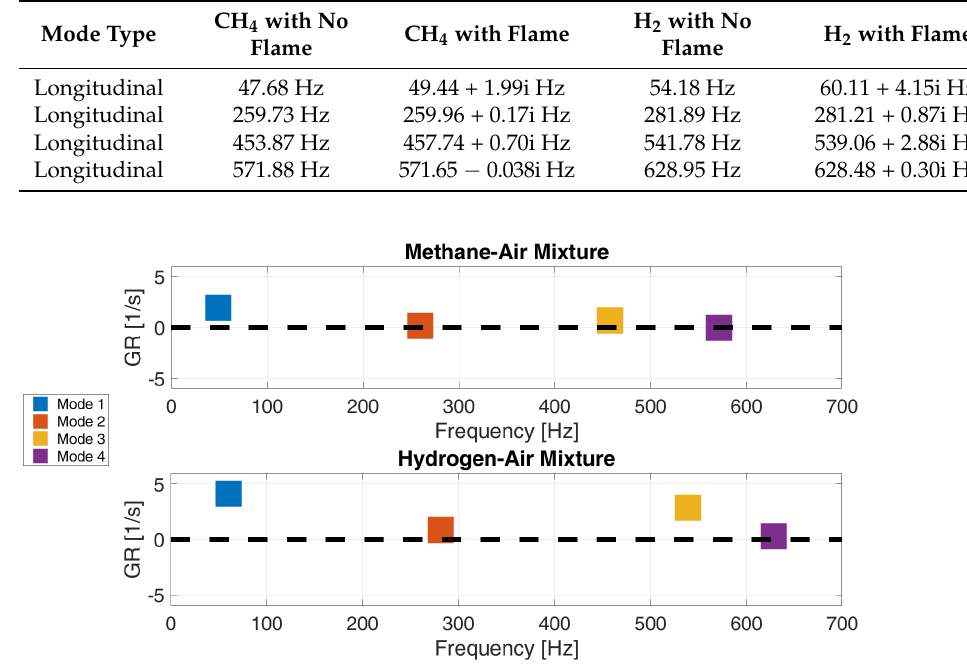
Table 4. Eigenmode comparisons between the H 2 –air and CH 4 –air mixtures.